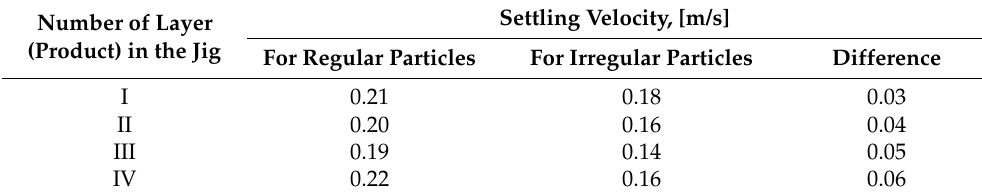
Table 1. Settling velocities for regular and irregular particles in individual layers (jig products). Settling Velocity, [m/s] Number of Layer (Product) in the Jig For Regular Particles For Irregular Particles Difference I